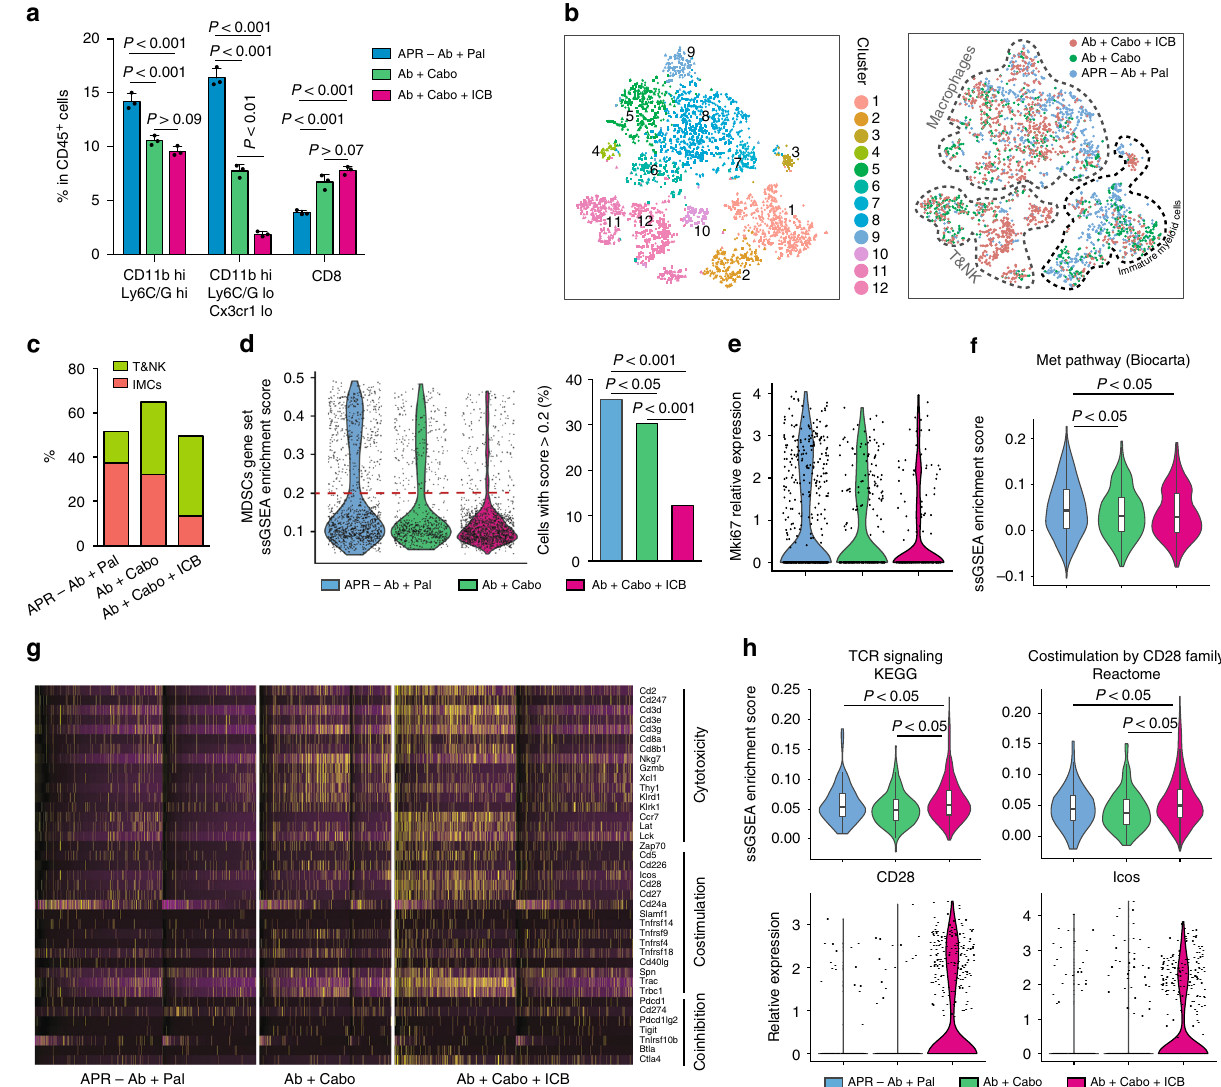
Fig. 4 Combining Cabo and ICB subverts immunosuppressive TME and enhances anti-tumor immunity. a Characterization of tumor in fi ltrated immune cell populations by CyTOF and their relative abundance among CD45 + TILs after treatment with Cabo and ICB. Error bars represent SD. b Clustering and annotation of scRNA-seq data including 3168 TILs derived from APR tumors with continuous Ab + Pal, Ab + Cabo or Ab + Cabo + ICB treatment. Left, t- SNE plot colored by clusters; right, annotation of TIL-clusters on t-SNE plot colored by treatment groups. c Abundance of T and NK-cell and IMC clusters (as clustered and annotated in b ) in the TILs with indicated treatment. d Distribution of MDSCs-related signature enrichment score (left) and proportion of cells with high enrichment score in the TILs with indicated treatment (right). MDSCs-related signature was generated from experiment in Fig. 2g (top 300 differential expressed genes of MDSC population) was used for enrichment analysis. e Expression of Ki67 in IMC population from tumors with indicated treatment. f Enrichment of ‘ Met pathway ’ in IMC population from tumors with indicated treatment. g The heatmap of T-cell response signature genes across CD45 + TILs. Speci fi c genes from gene sets for T-cell cytotoxicity, costimulation, and coinhibition were shown. Each column represents a single cell. h Enrichment scores for ‘ T-cell receptor signaling ’ and ‘ Costimulation by the CD28 family ’ (upper panel) and expression of CD28 and ICOS (lower panel) in T&NK cell population (as clustered and annotated in b ). Each point represents a single cell in b , d , e , h . P -value by one-way ANOVA with Tukey ’ s test in a , by three-sample Chi-square test in d and by two-tailed Student ’ s t test in f and